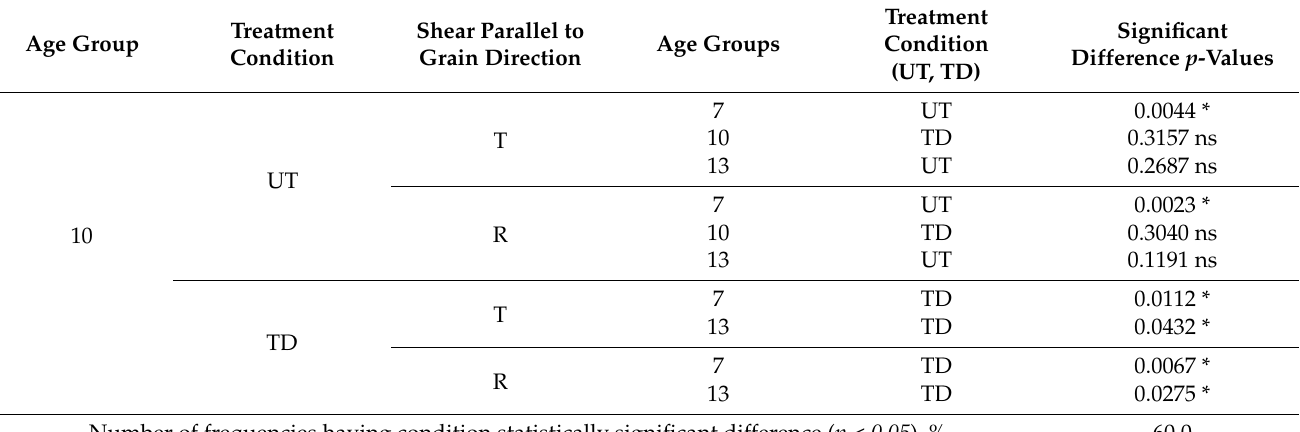
Table 3. ANOVA on the effect of age groups, treatment conditions, and grain directions with 10-year- old untreated and treated for shear parallel to grain of Acacia hybrid samples at air-dry condition.